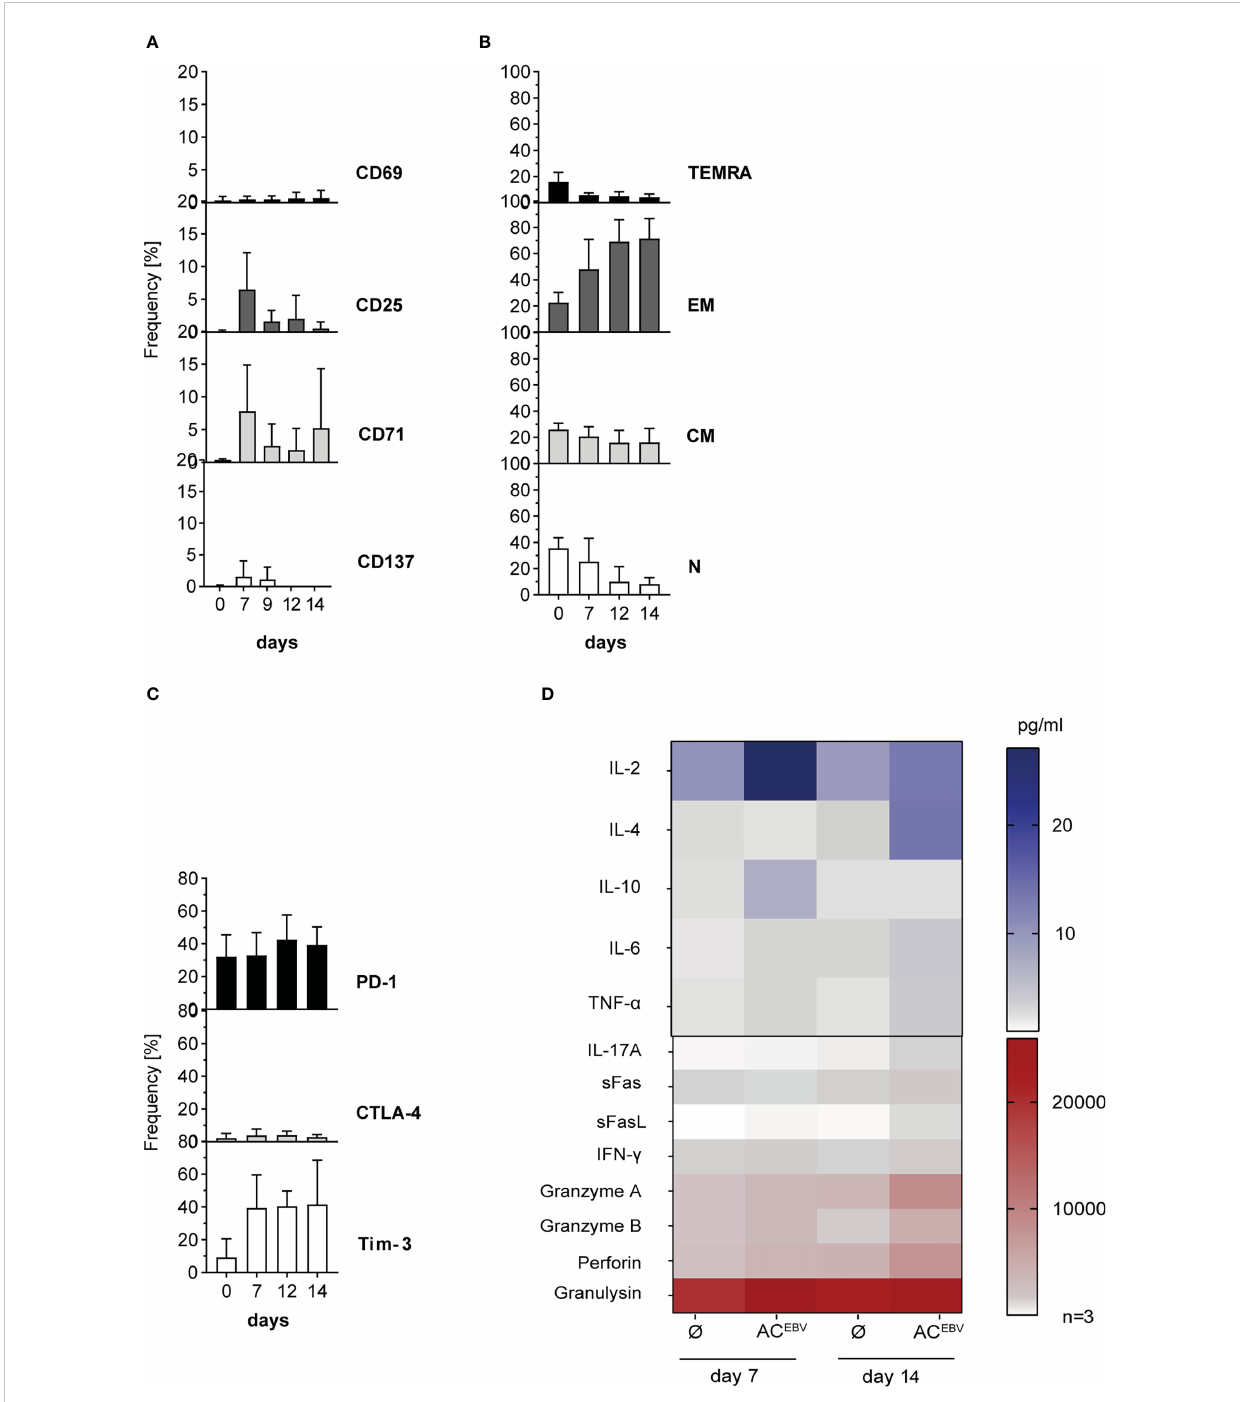
FIGURE 7 Phenotypic and functional characterization of EBV-speci fi c memory T cells after long-term stimulation with AC EBV -loaded B-LCLs. CD3 + T cells characterized for (A) activation, (B) memory phenotype composition (N - naïve, CM - central memory. EM - effector memory, TEMRA - effector memory RA), and (C) exhaustion after long-term stimulation with autologous B-LCLs from EBV-seropositive donors loaded with the EBV antigen cocktail (AC EBV ) on different days (day 0/7-14). For activation markers, the background of cells stimulated with unloaded B-LCLs (control) was subtracted from the corresponding sample, while for the exhaustion marker, a FMO ( fl uorescence minus one) was used as a control and subtracted for the corresponding sample. Results of three independent experiments are expressed as mean ± SD. Statistical analysis was performed using the 2way ANOVA test followed by multiple comparison. (D) Cell culture supernatants from 7 and 14 day T-cell stimulation assays were analyzed with respect to presence of cytotoxic effector molecules by LEGENDPlex Assay (n=3) and are displayed as heat maps. The values are represented by different colors, as referenced in the bar. Statistical analysis was performed using the 2way ANOVA test followed by multiple